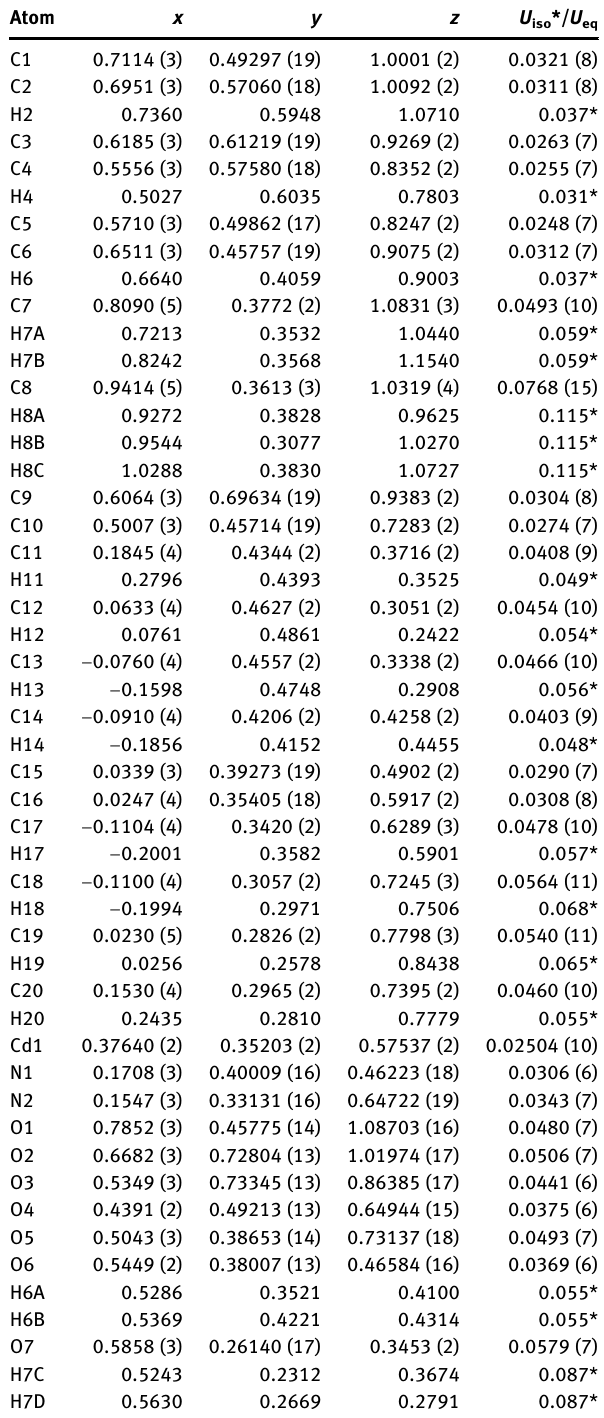
Table  : Fractional atomic coordinates and isotropic or equivalent isotropic displacement parameters (Å 